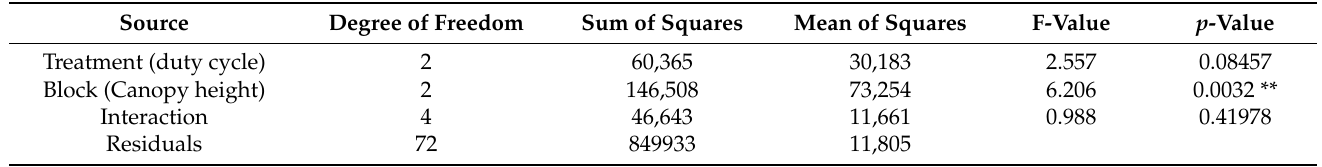
Table 4. ANOVA analysis for droplet density (* p ≤ 0.05, ** p ≤ 0.01).